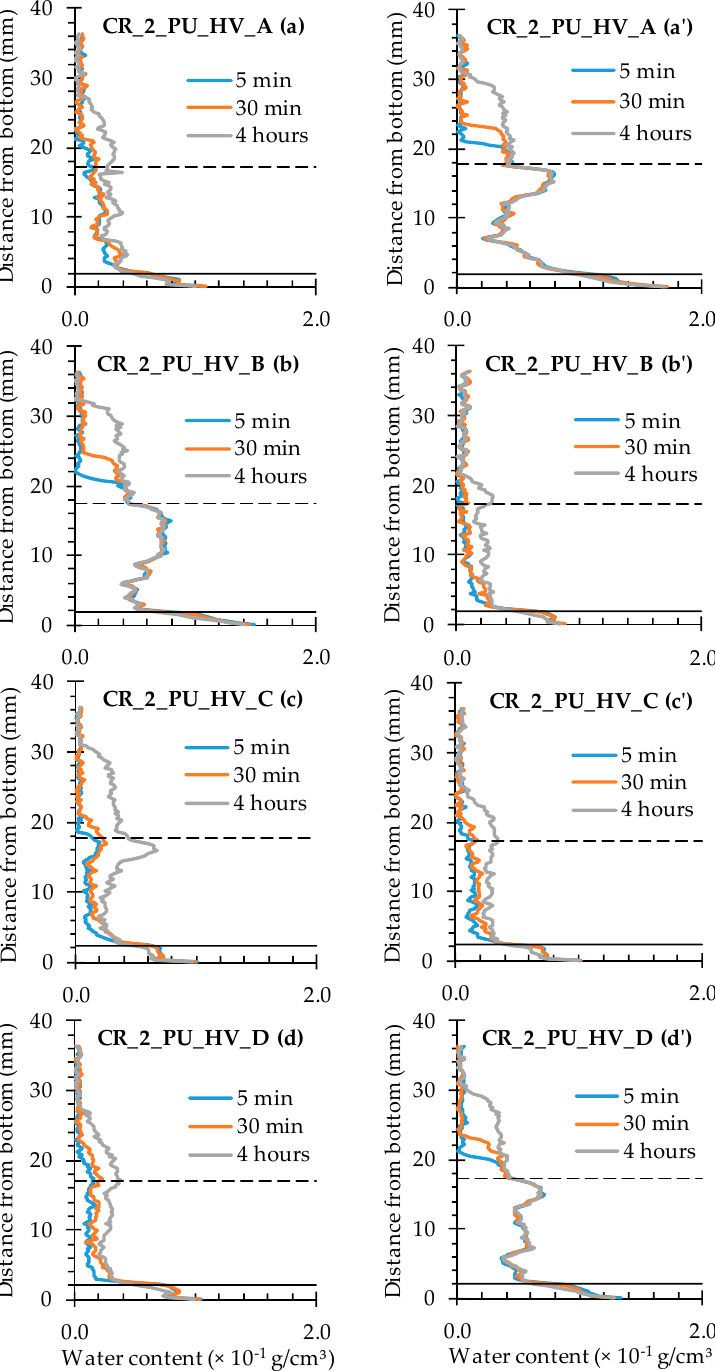
Figure 20. Water profiles along the crack as a function of exposure time for the neutron radiography images of the four standard mortar prisms containing two artificial cracks healed with PU_HV: ( a ) CR_2_PU_HV_A crack on the left; ( a’ ) CR_2_PU_HV_A crack on the right; ( b ) CR_2_PU_HV_B crack on the left; ( b’ ) CR_2_PU_HV_B crack on the right; ( c ) CR_2_PU_HV_C crack on the left; ( c’ ) CR_2_PU_HV_C crack on the right; ( d ) CR_2_PU_HV_D crack on the left; and ( d’ ) CR_2_PU_HV_D crack on the right.